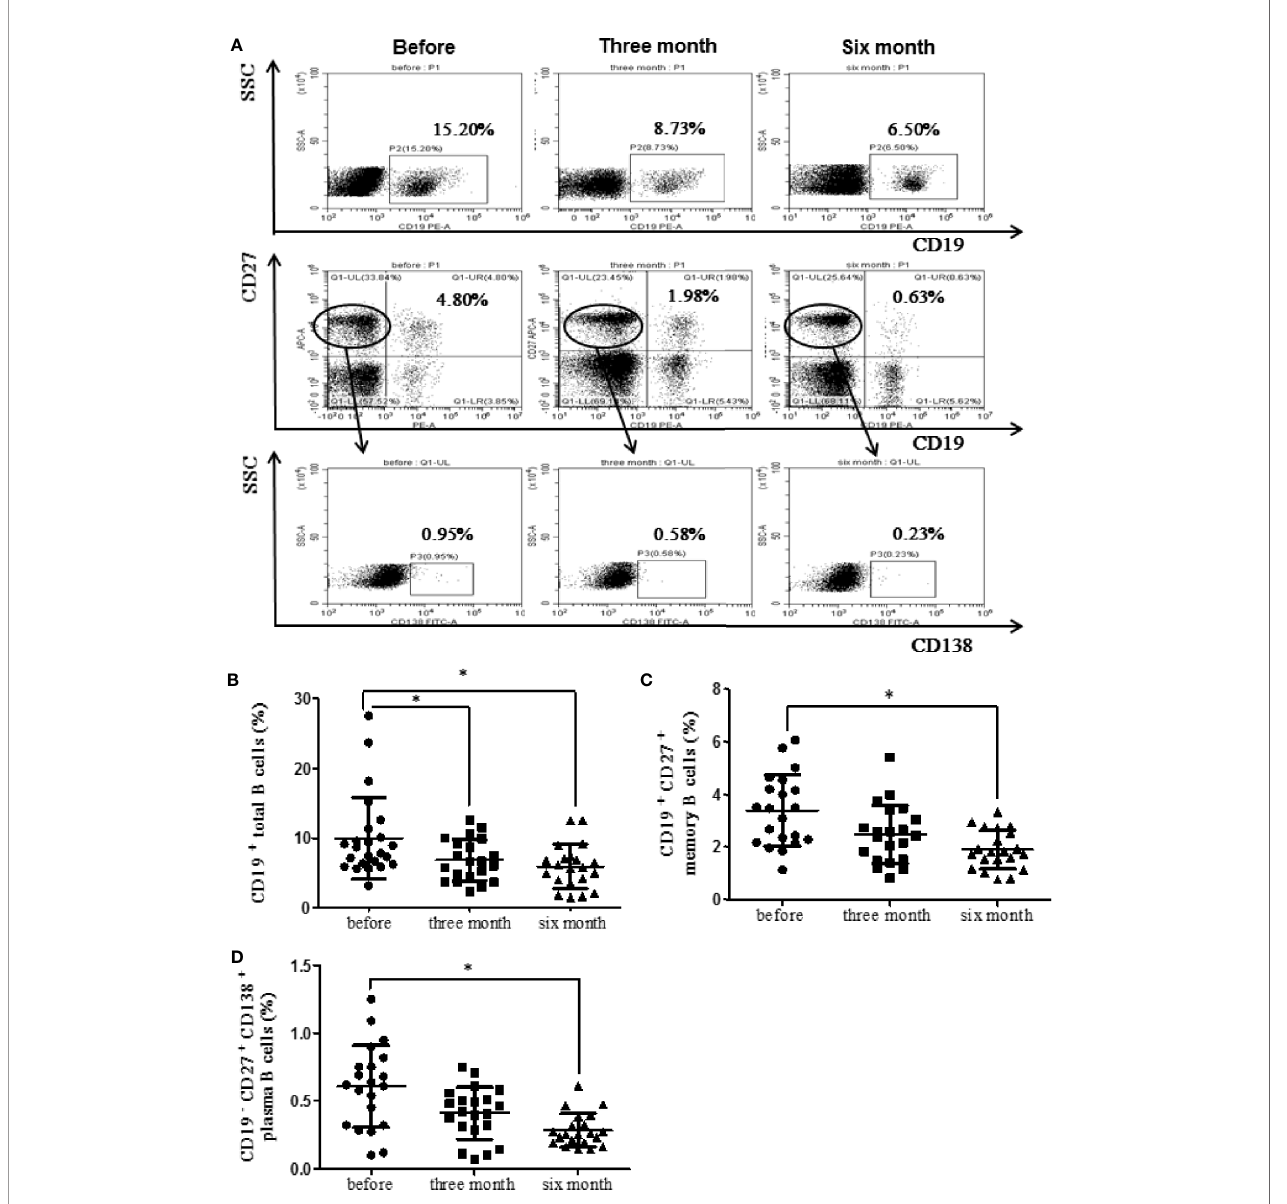
FIGURE 2 | Etanercept could down-regulate the percentage of peripheral blood B cell subsets in patients with RA. (A) The representative fl ow cytometry graphs of one RA patients ’ B cell subsets. (B) The percentage of CD19 + B cells was analyzed by fl ow cytometry after etanercept treatment. (C) The percentage of CD19 + CD27 + B cells was analyzed by fl ow cytometry after etanercept treatment. (D) The percentage of CD19 − CD27 + CD138 + B cells was analyzed by fl ow cytometry after etanercept treatment. * p <